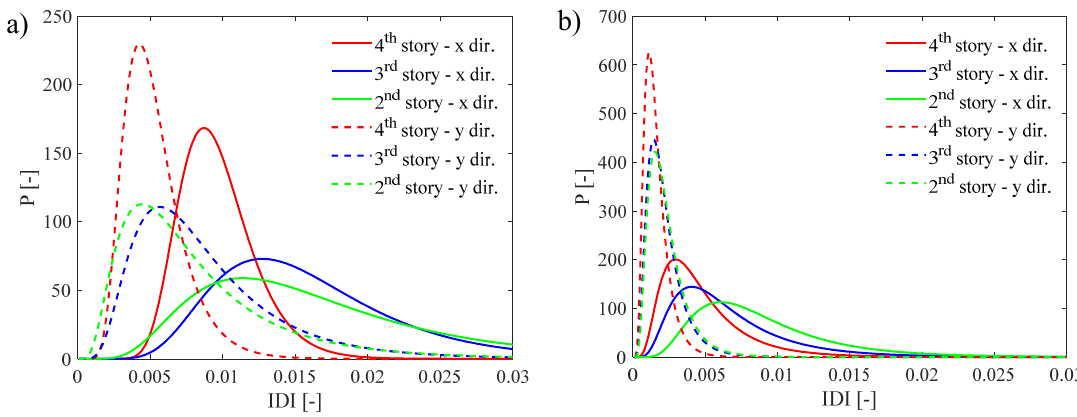
Figure 12. Lognormal monovariate PDFs for the IDIs in X and Y direction: FB model ( a ), BI model ( b ).